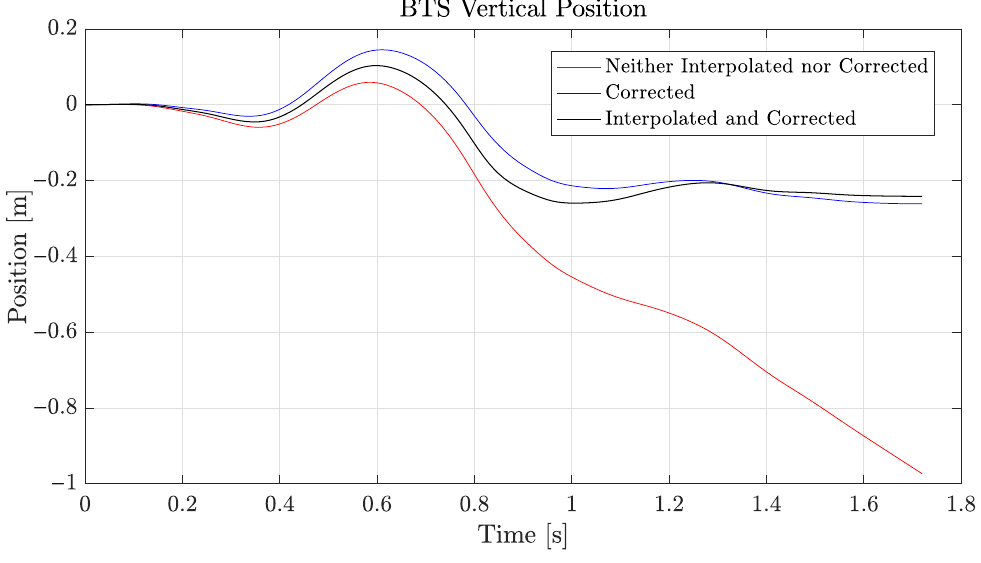
Figure 10. Vertical position (BTS sensor).